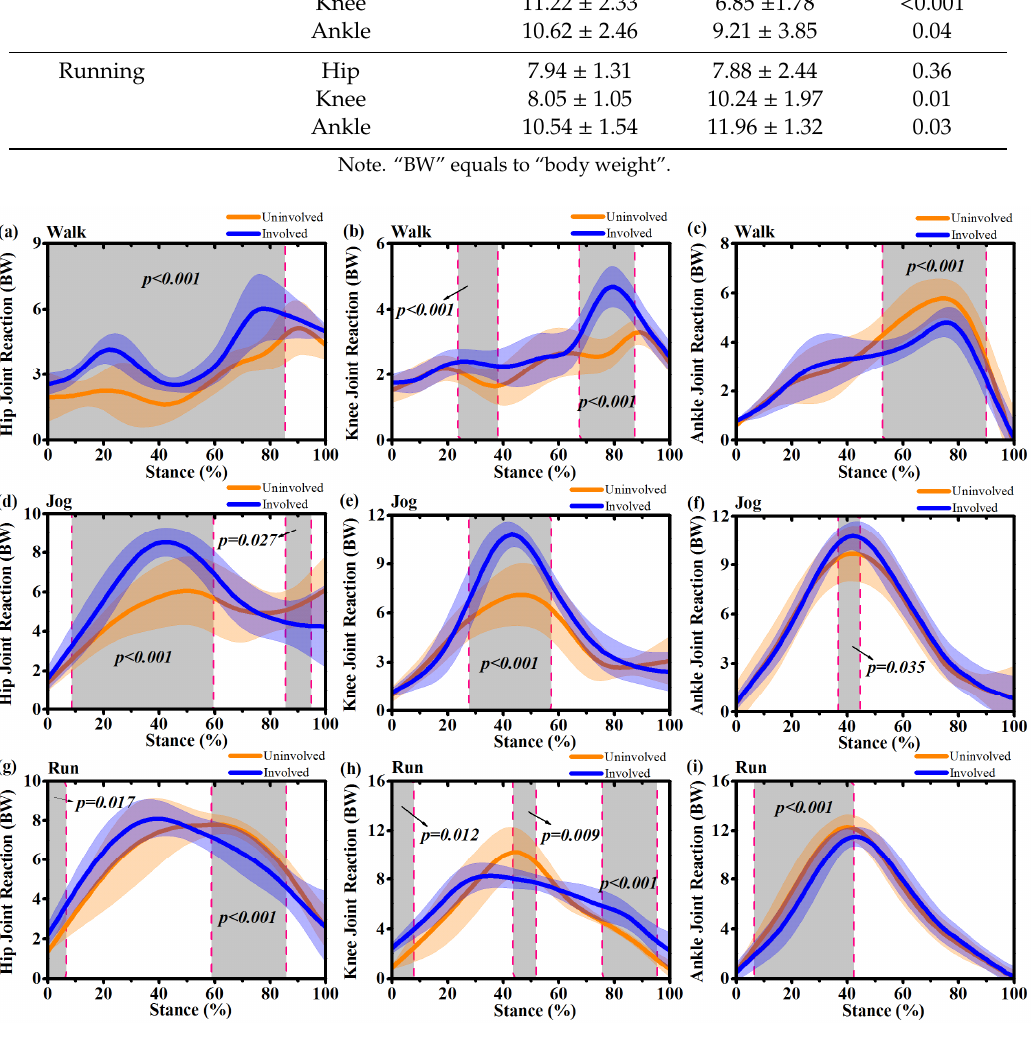
Figure 8. Mean and standard deviation of estimated joint reaction forces waveforms over stance at the hip, knee and ankle joints for uninvolved side (yellow) and involved side (blue) during walking, jogging and running. ( a ): Hip joint reaction forces during stance phase of walking; ( b ) Knee joint reaction forces during stance phase of walking; ( c ) Ankle joint reaction forces during stance phase of walking; ( d ): Hip joint reaction forces during stance phase of jogging; ( e ) Knee joint reaction forces during stance phase of jogging; ( f ) Ankle joint reaction forces during stance phase of jogging; ( g ): Hip joint reaction forces during stance phase of running; ( h ) Knee joint reaction forces during stance phase of running; ( i ) Ankle joint reaction forces during stance phase of running. Grey shaded regions on graphs indicate a significant difference between the two sides ( p < 0.05) from SPM1d analyses. Table 6. The peak joint reaction forces of the involved side (IS) and the uninvolved side (US) during walking, jogging and running movements.